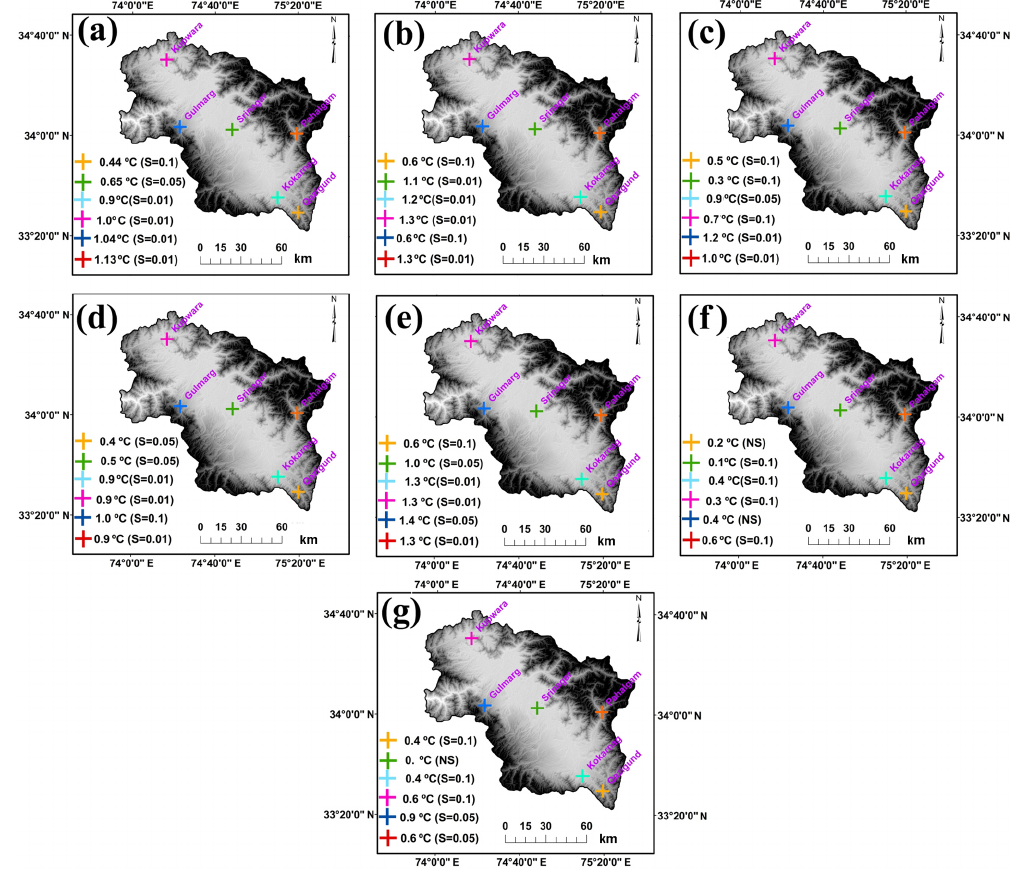
Figure 2. Trends in surface temperature ( ◦ C) at the six interested locations of the Kashmir valley (a) for annual mean temperature, (b) maxi- mum temperature, (c) minimum temperature, (d) winter mean temperature during December–February, (e) spring mean temperature (March– May), (f) summer mean temperature (June–August) and (g) autumn mean temperature